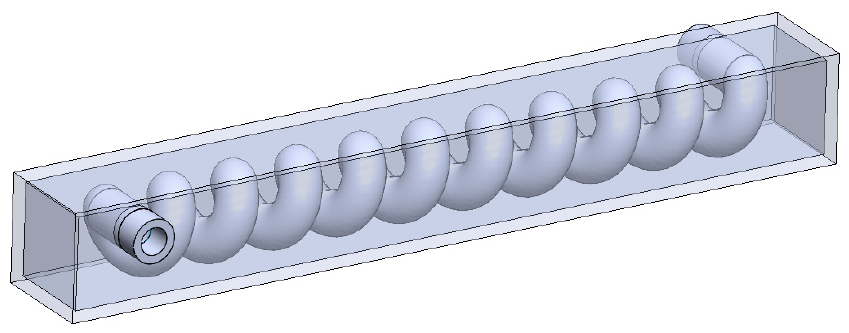
Figure 3. Helical pipe configuration.